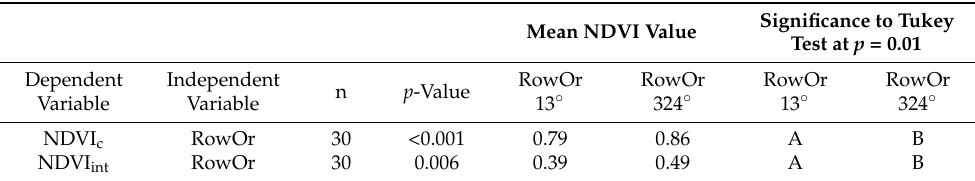
Table 3. ANOVA of NDVI c and NDVI int data collected within the same range of SELV values in two blocks with different row